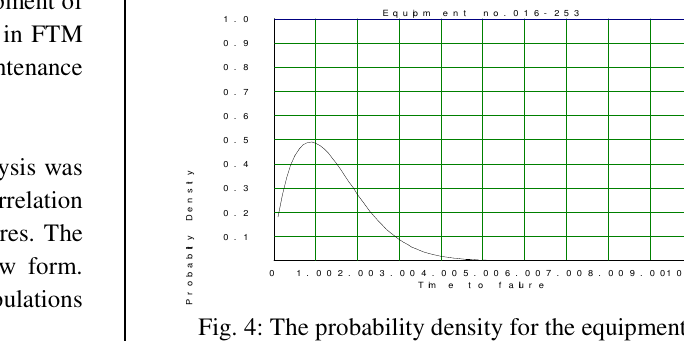
Fig. 4: The probability density for the